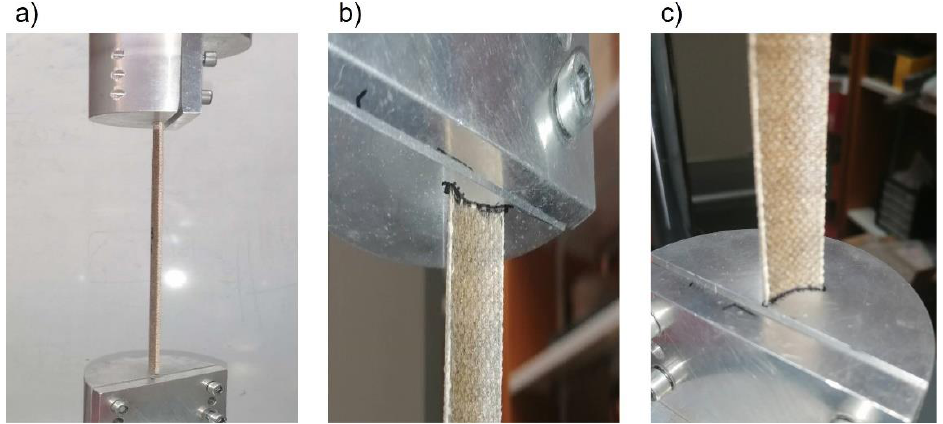
Figure 7. Buckling test of C90 column: ( a ) general view, ( b ) detail of upper support, ( c ) detail of bottom support.